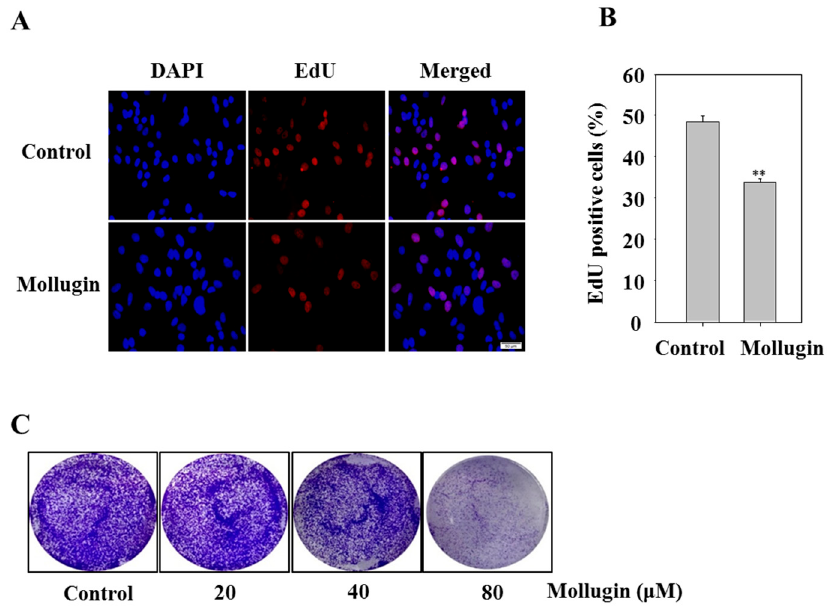
Figure 5. Effect of mollugin on HeLa cell proliferation. ( A , B ) Hela cells were treated with 80 µ M mollugin for 12 h. After EdU labeling, the data were collected using fluorescent microscope at 20 × magnification (scale bar: 50 µ m); ** p < 0.01 compared to control group; ( C ) HeLa cells were treated with indicated concentrations of mollugin (20, 40, and 80 µ M) for 12 h, and then the medium was replaced by a fresh medium. Cells were allowed to grow for 10 days and subjected to crystal violet staining of cell growth. The diameter of each well was 34.8 mm.